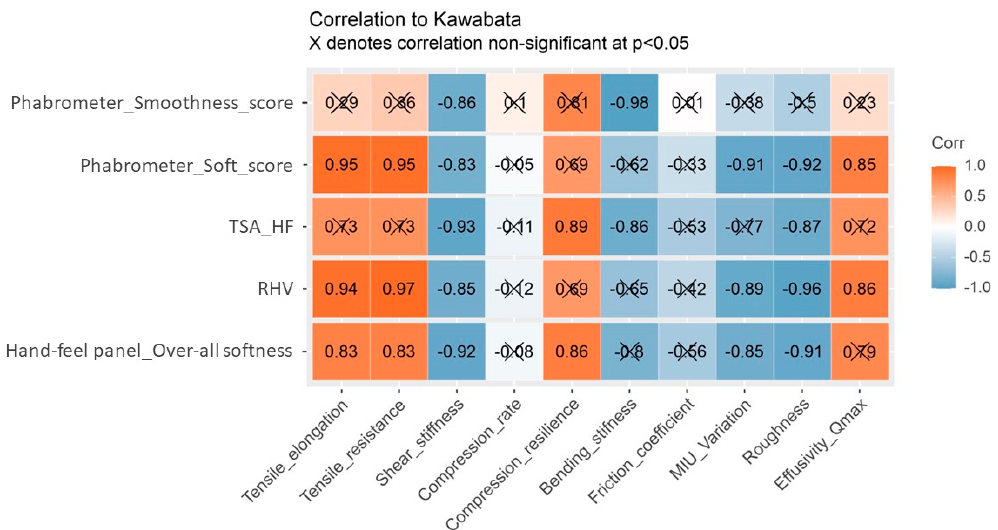
each Kawabata parameter, is shown in Figure 6.